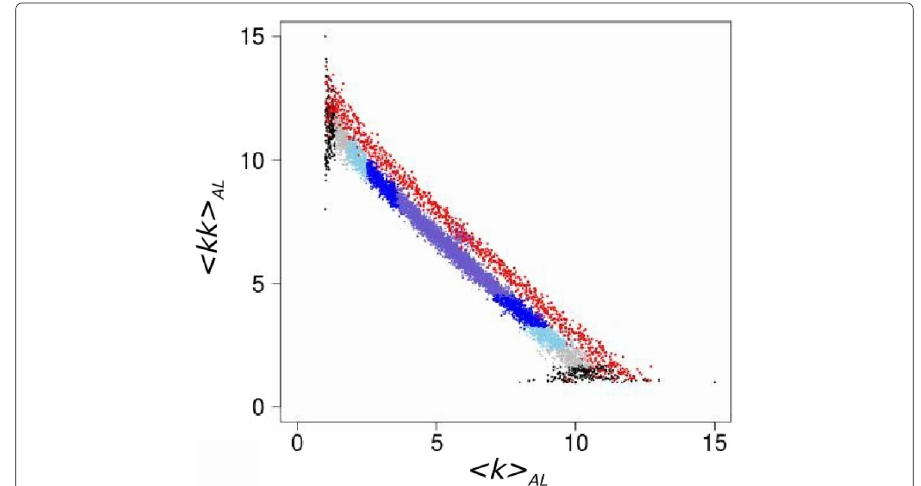
Fig. 4 Degree correlations of G AL for each agent of G AL separating nodes according to its opinion state for different values of ρ . 100 realizations of N = 1000 agents with an underlying network of contacts of Erdos-Renyi of < k > = 12. Each step of each realization contributes with two points to the plot: one for − 1. Different colors are used to < kk > AL of the population of agents in state 1 and one for agents in state identify different ranges of values of ρ . Red points correspond to the case in which the states of the agents are assigned at random and the G AL is determined from this random assignation